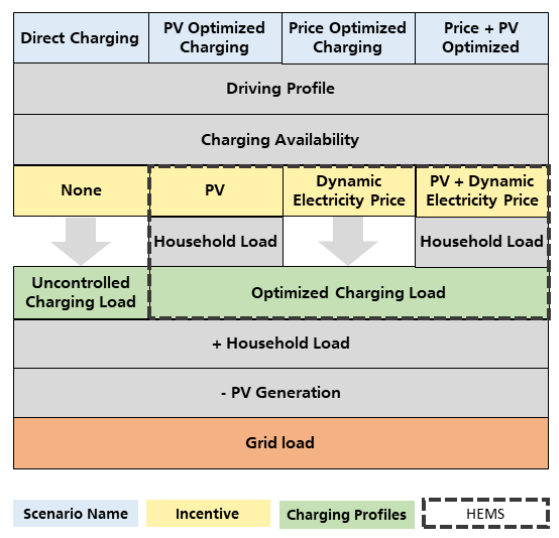
Figure 2. Procedure for the generation of the charging load time series and the grid load caused by the households.